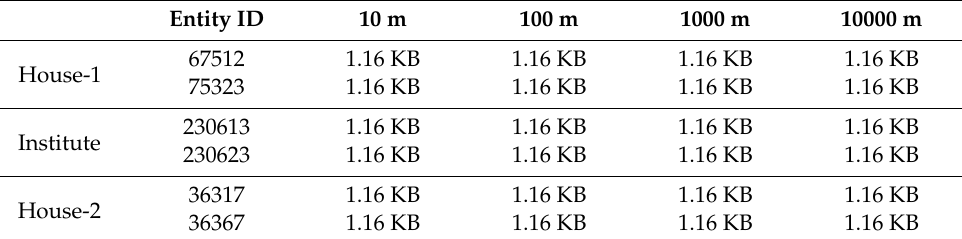
Table 7. Boundary sizes and file size of corresponding B-Reps for half spaces.